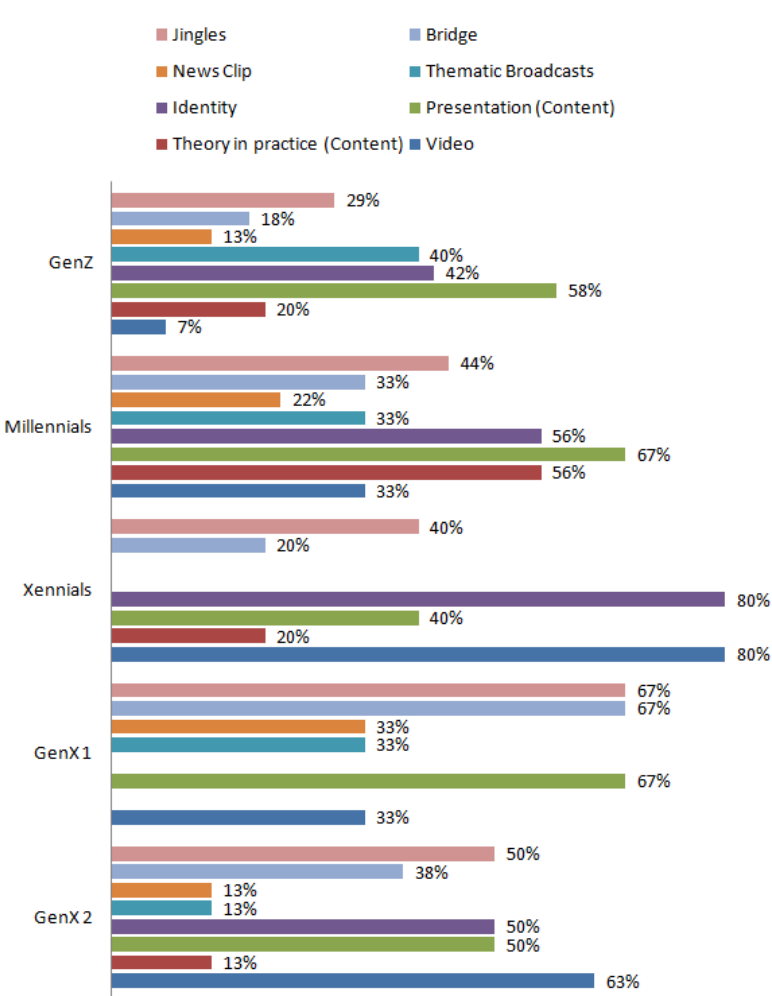
Figure 5. Grouped and adjusted qualitative data as quantitative data from the second part of the evaluation form based in age groups (genealogical cohorts).